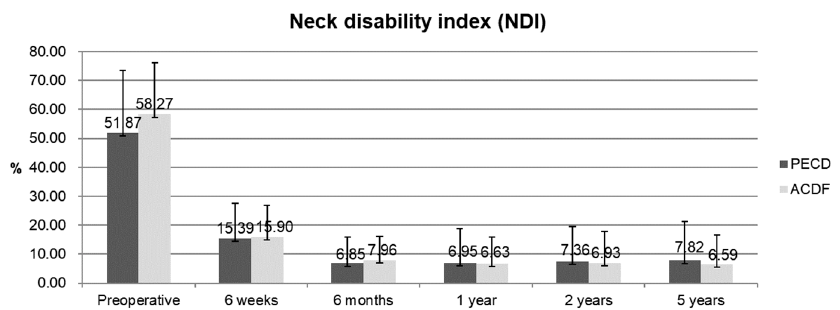
Figure 3. The Neck Disability Index (NDI) preoperatively and at six weeks, six months, one year, two years, and five years postoperatively. There were no significant differences between the groups. PECD, percutaneous endoscopic cervical discectomy; ACDF, anterior cervical discectomy and fusion.